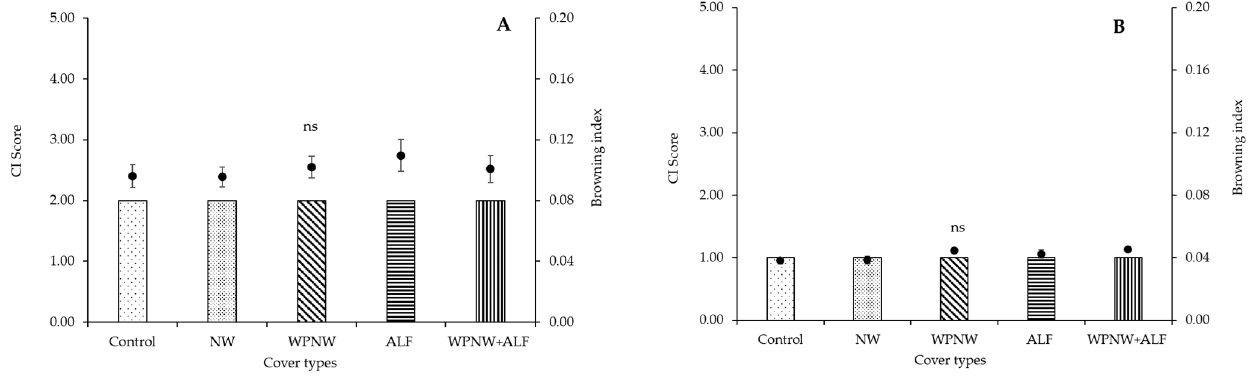
Figure 7. Chilling injury (CI) score and browning index of banana at mature green stage from the winter trial ( A ) and summer trial ( B ).